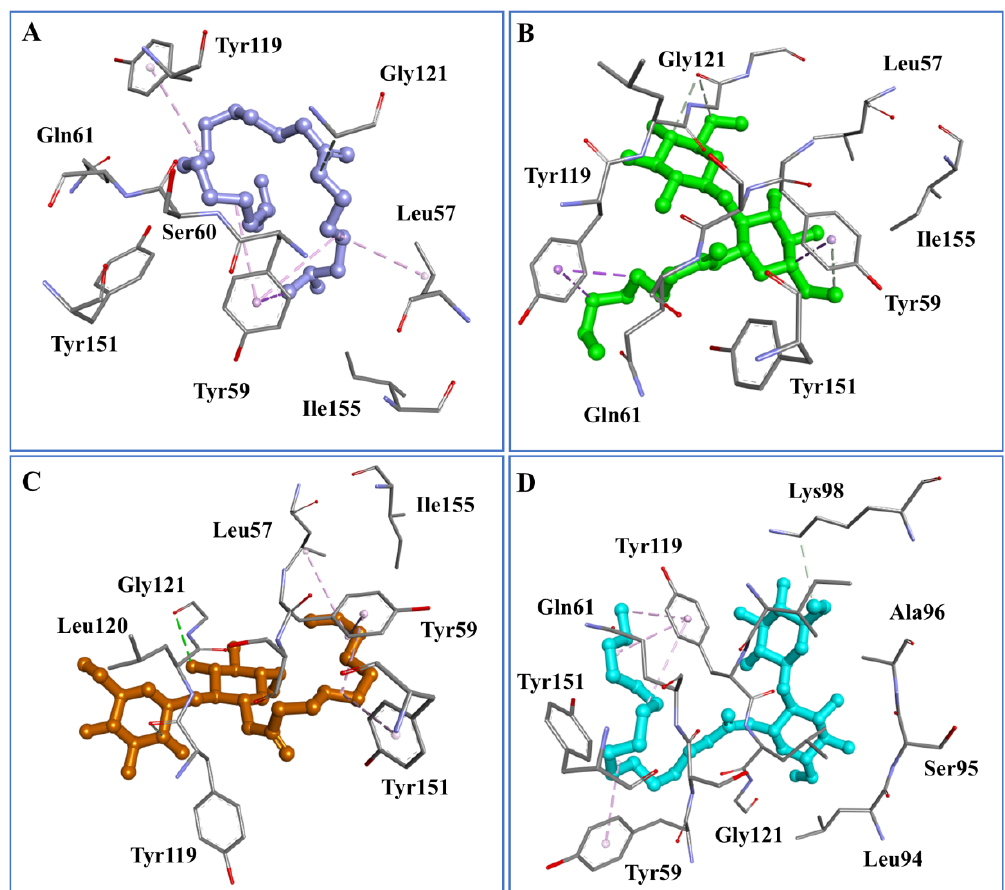
Figure 5. Docked complexes of Molecule 1 ( A ), Molecule 2 ( B ), Molecule 3 ( C ), and Molecule 4 ( D ) in the binding pocket of TNF-alpha (PDB ID: 2AZ5_A). The interacting residues of the protein are shown in the stick view, whereas molecules 1–4 are shown in the ball and stick. The images were drawn in Biovia Discovery Studio Visualizer. Table 2. Estimated potential energy values for the isolated molecules after energy minimization.